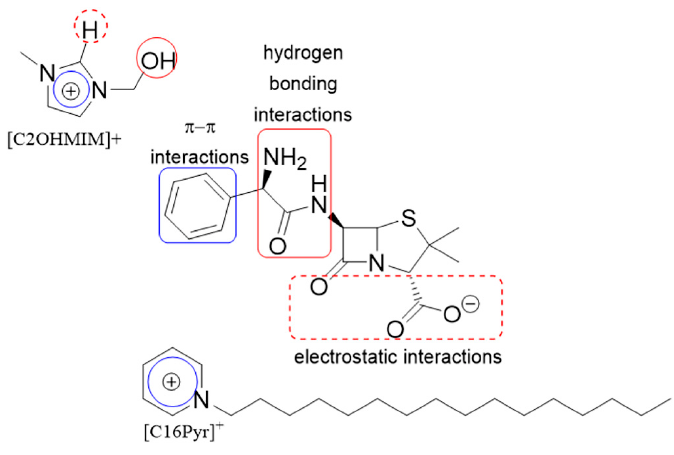
Figure 4. Structure of [C2OHMIM][Amp] and [C16Pyr][Amp] with their possible cation–anion interactions.